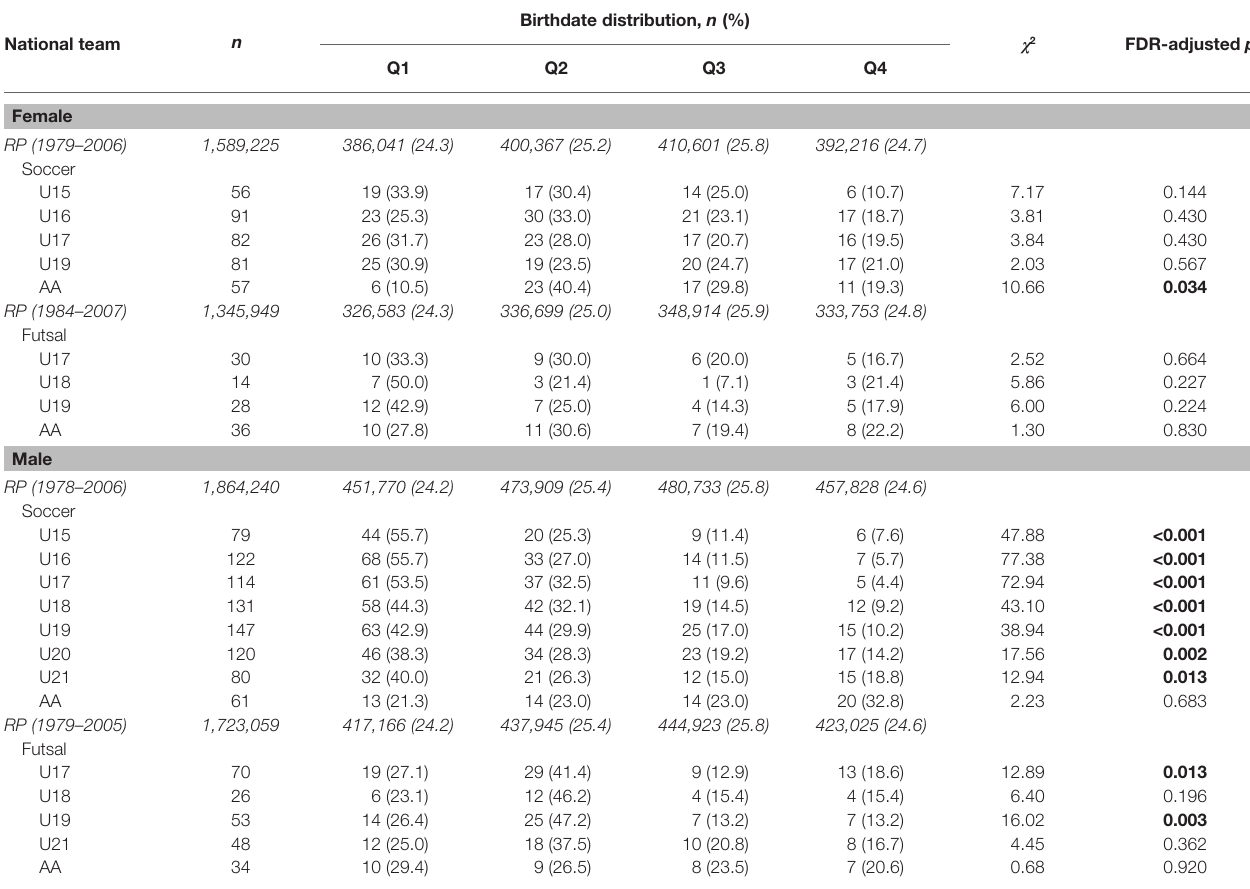
Birthdate distribution, n